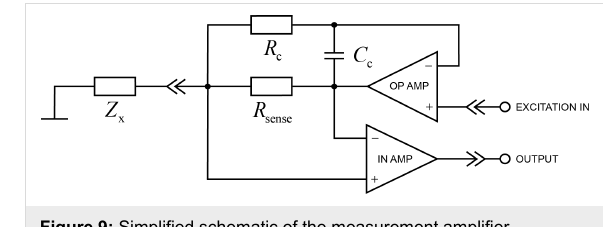
Figure 9: Simplified schematic of the measurement amplifier.